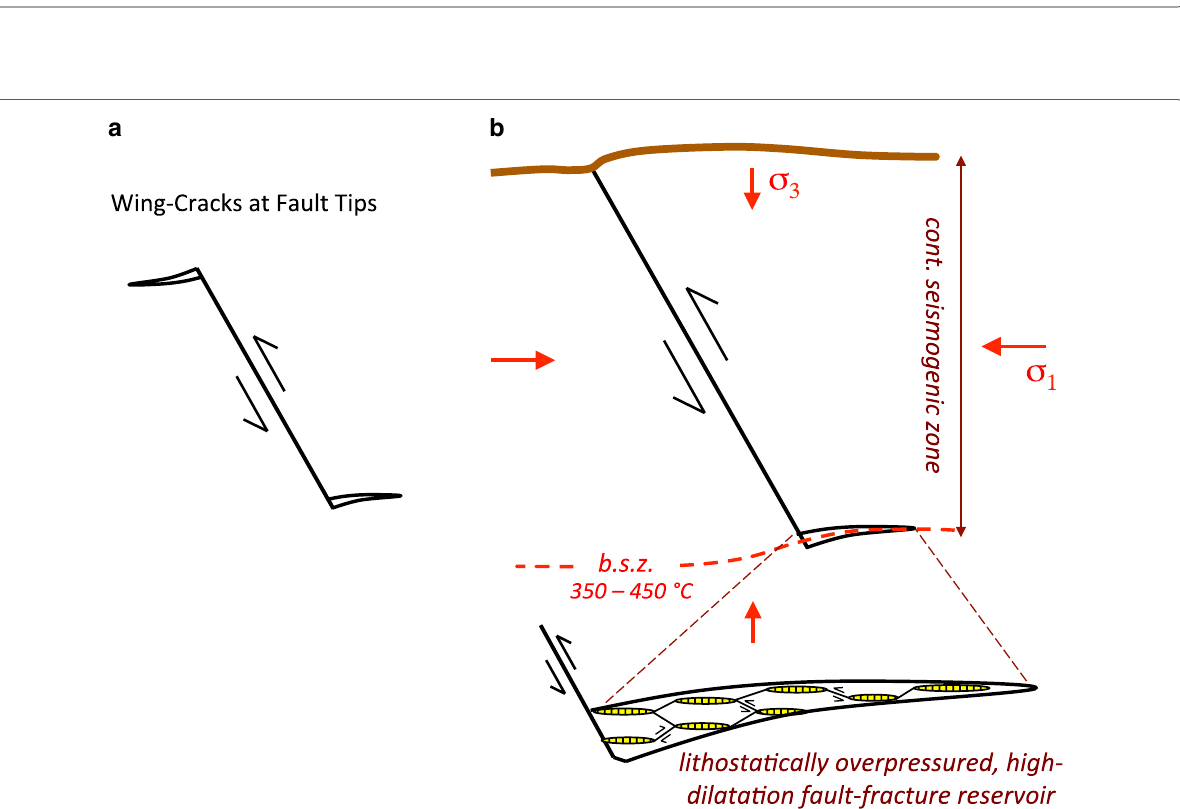
Fig. 10 a Development of wing-cracks at the tip of a steep reverse fault under horizontal compression within intact crust (cf. Willemse and Pollard 1998); b hypothetical development of an overpressured fluid reservoir near the base of the upper crustal seismogenic zone, in the dilatational quadrant associated with the termination of a steep reverse